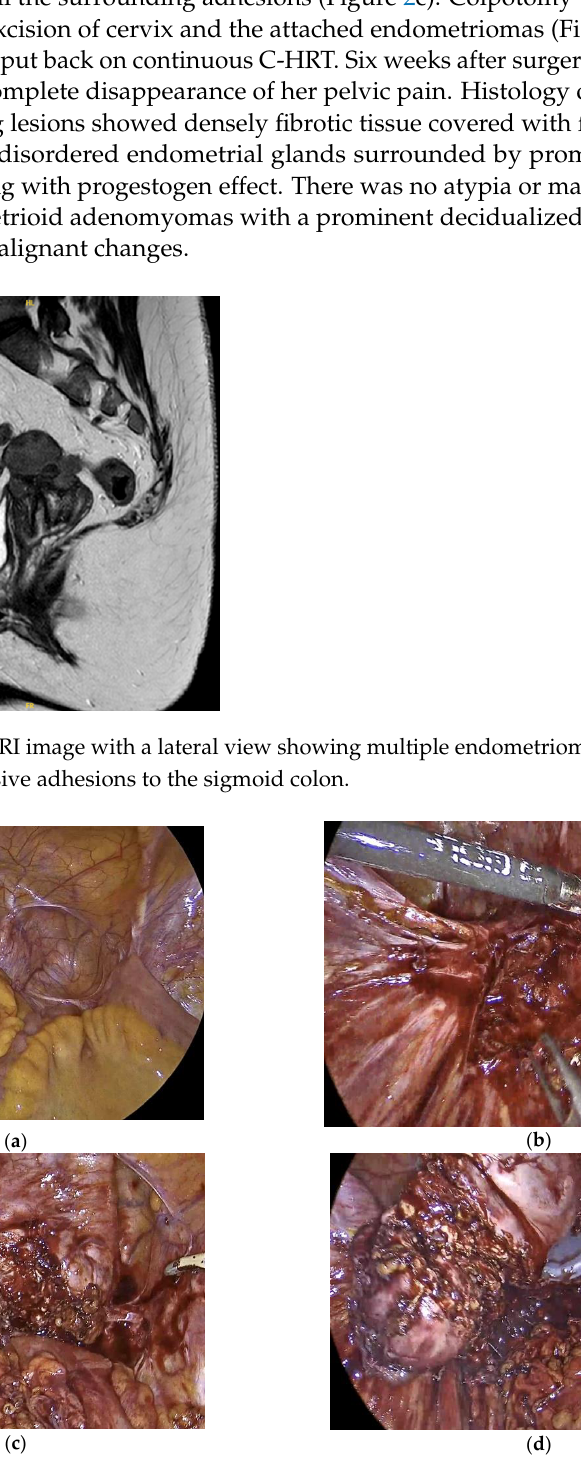
Figure 2. Laparoscopic images of extensive adhesiolysis and excision of peri-cervical endometriomas and cervical stump ( a ) Pelvic survey showing complete obliteration of pelvis with sigmoid adhesions; ( b ) Peri-cervical endometriomas revealed after complete mobilization of bowel; ( c ) Cervical stump completely dissected from surrounding adhesions and bowel; ( d ) Colpotomy with complete excision of cervix with the attached endometriomas.